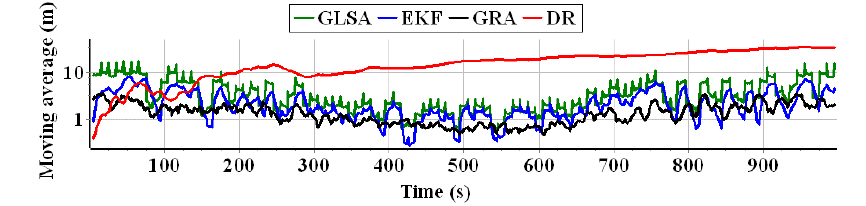
Figure 18. Moving average distance to the reference position from the estimated position during a single SV crossing as a function of time (logarithmic scale—log base =